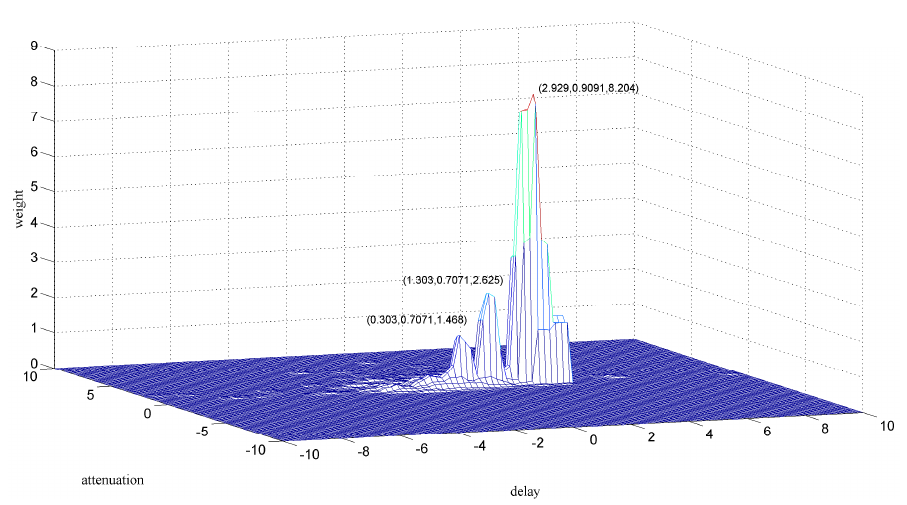
Figure 11. Clustering result of section a2 into three particles.